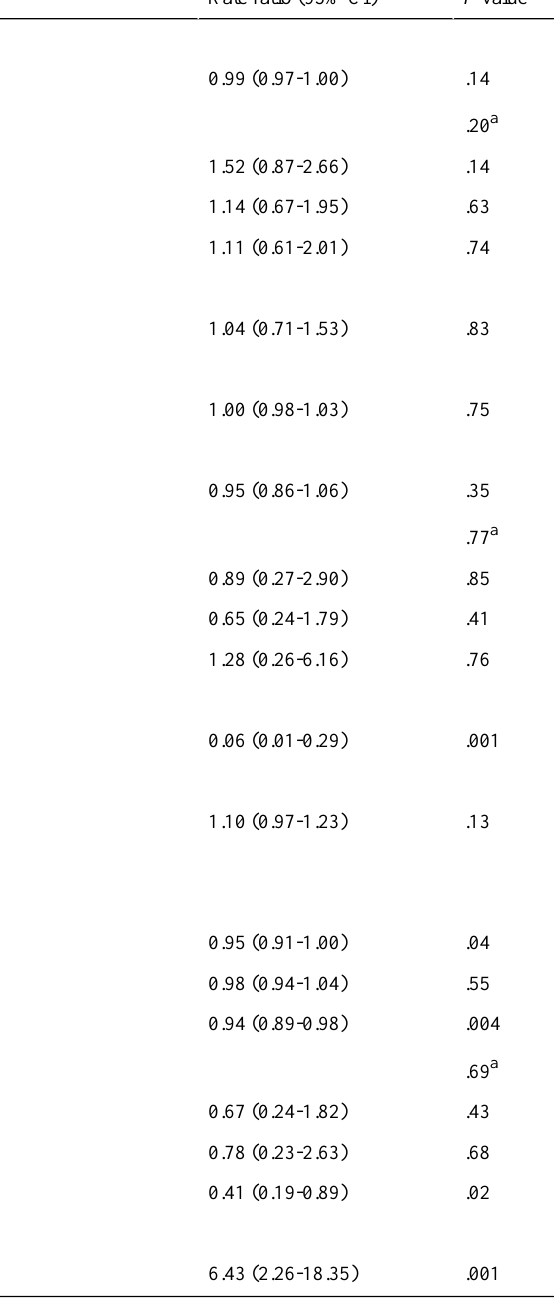
P valueRate ratio (95% CI)Variable and category